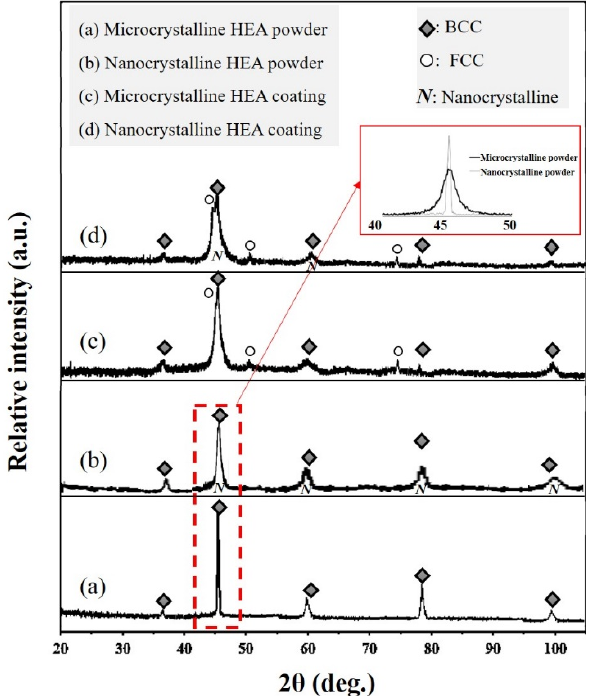
Figure 5. ( a , b ) XRD pattern for micro- and nanocrystalline AlCrFeCoNi HEA powder, ( c , d ) for as-sprayed micro- and nanocrystalline AlCrFeCoNi HEA coatings obtained from milled 5 and 25 h powder feedstock, respectively.